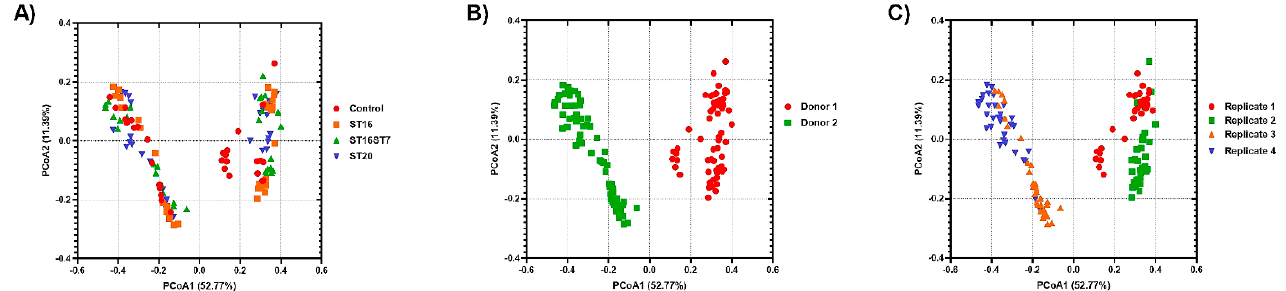
Figure 3. Plots of principal coordinate analysis (PCoA) based on Bray–Curtis distances among the identified microbiota in different samples, showing clustering based on treatment ( A ); donor ( B ), and replicate ( C ). The samples were colored as indicated in the legends. PCoA1 and PCoA2 represent the top two coordinates that captured the highest microbial variability among samples, and the percentage shown indicates the fraction of variation represented by each coordinate. Permutational multivariate analysis of variance (PERMANOVA) was used to test for the statistical significance of sample